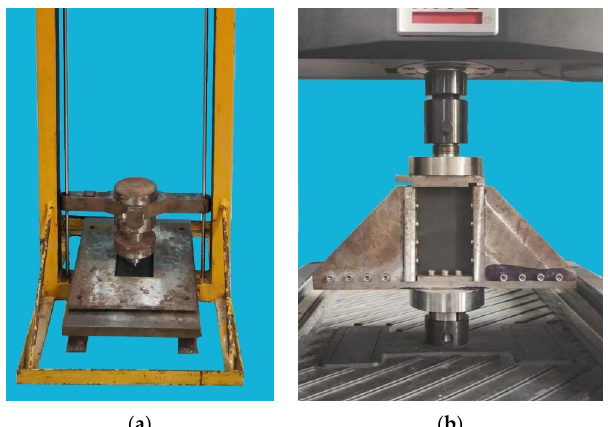
Figure 1. Devices for the CAI test. ( a ) Impact test device. ( b ) Compression test device.